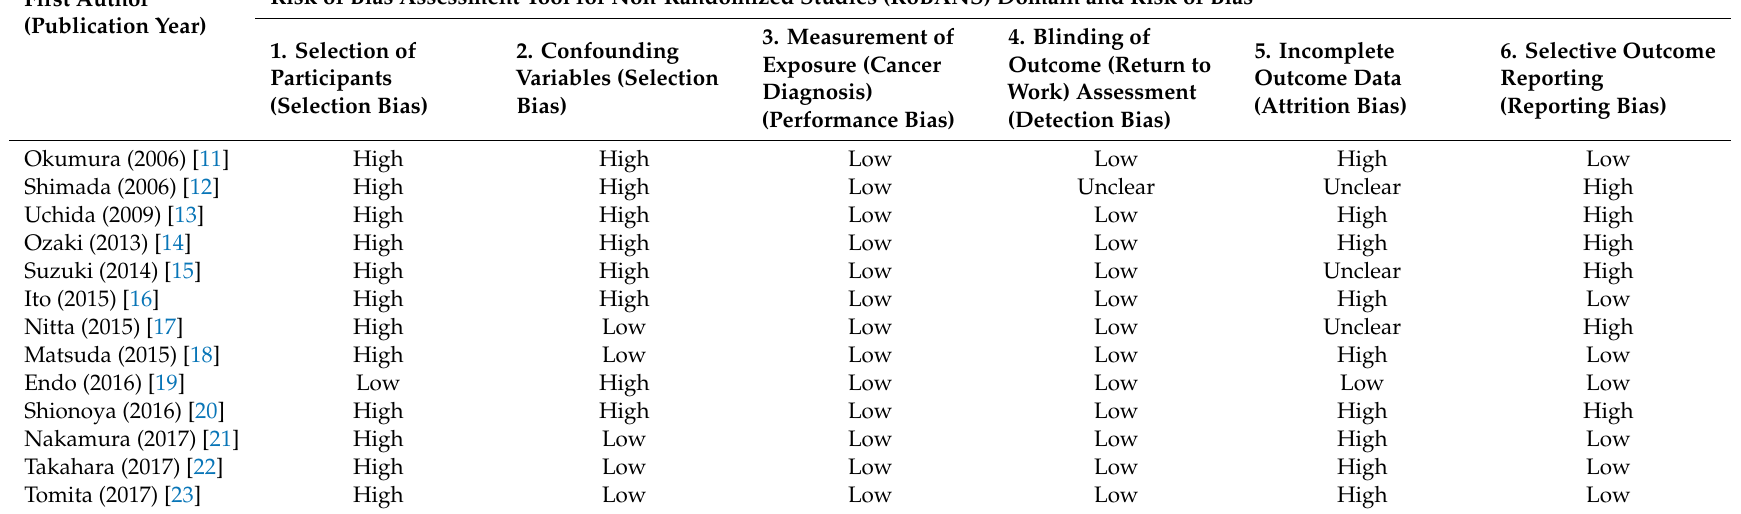
Table 2. Methodological quality assessment of selected